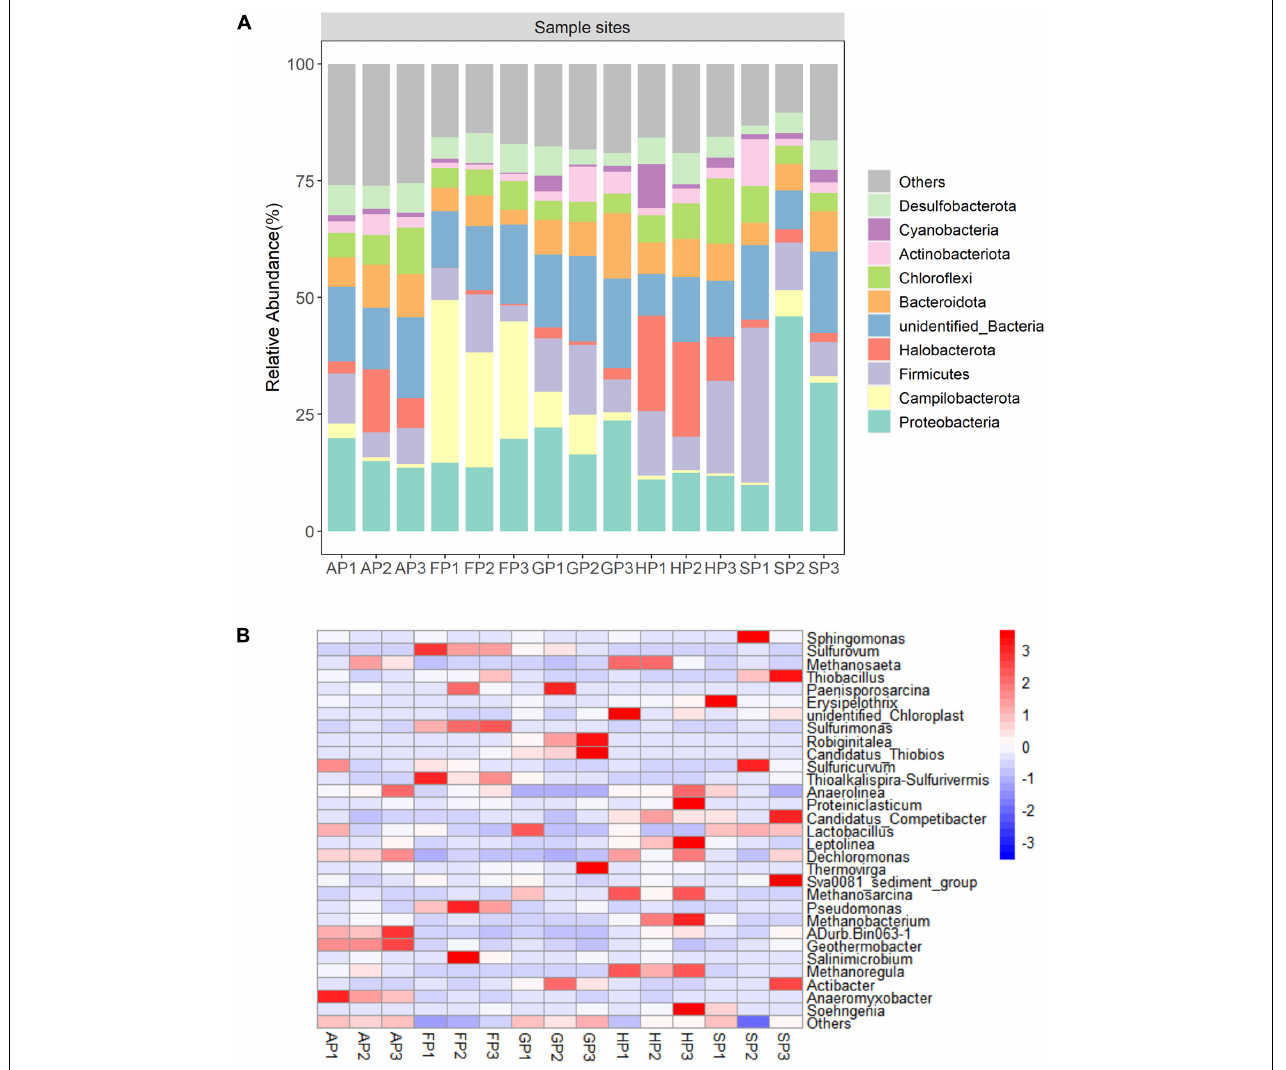
FIGURE 2 | (A) Relative abundance of top 10 phyla in the 15 sediment samples. (B) The heatmap at the genus level of the 15 sediment